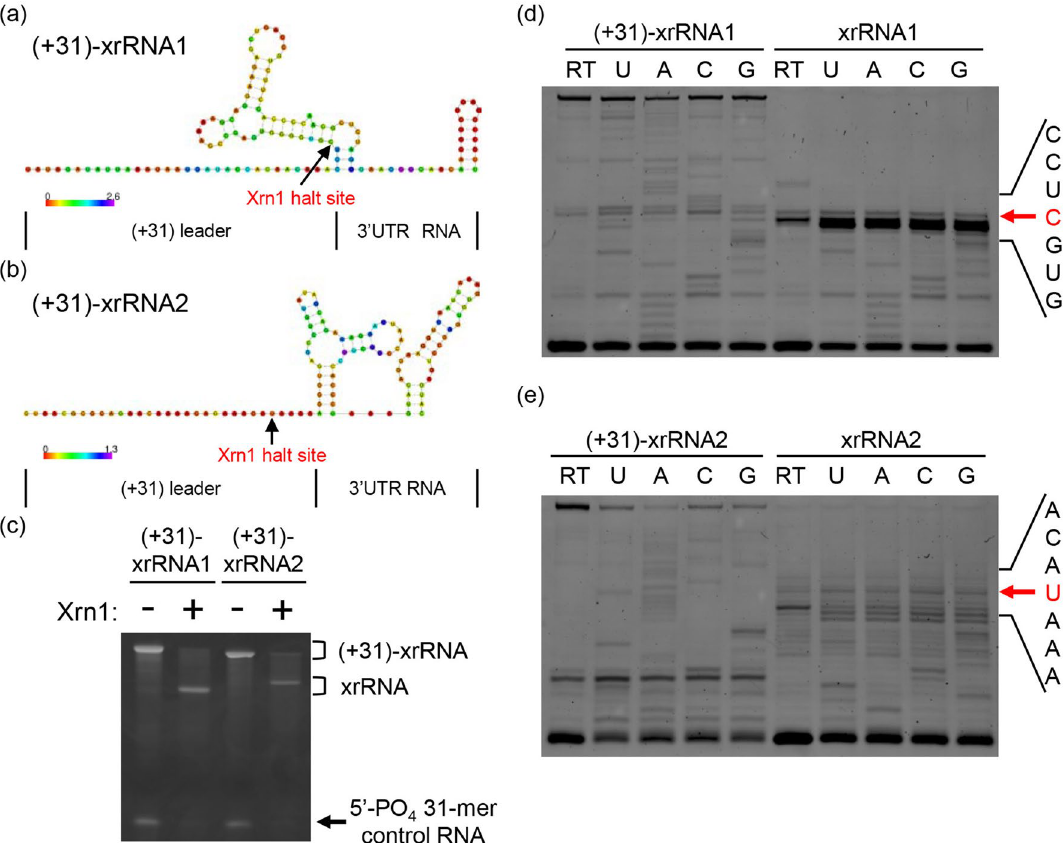
Figure 6. Xrn1 degradation assay and characterization of the Xrn1-resistant products. ( a , b ) Schematic diagram of predicted secondary structures of two RNA constructs, (+ 31)-xrRNA1 ( a ) and (+ 31)-xrRNA2 ( b ), used for structures. Heat scale bars represent bits of positional entropy. Black arrows indicate the Xrn1 halt sites. ( c ) In vitro Xrn1 degradation assay using (+31)-xrRNA1 and (+31)-xrRNA2. This image is a part of full-length gel represented in Supplementary Fig. S3a. ( d , e ) Reverse transcription mapping the Xrn1 halt sites with RNA from panel ( c ). The location of the stop site (the 5 ′ border of the RNA products) is shown with a red arrow to the right, along with the sequence of the RNA surrounding this position. These images are parts of full-length gels represented in Supplementary Fig.